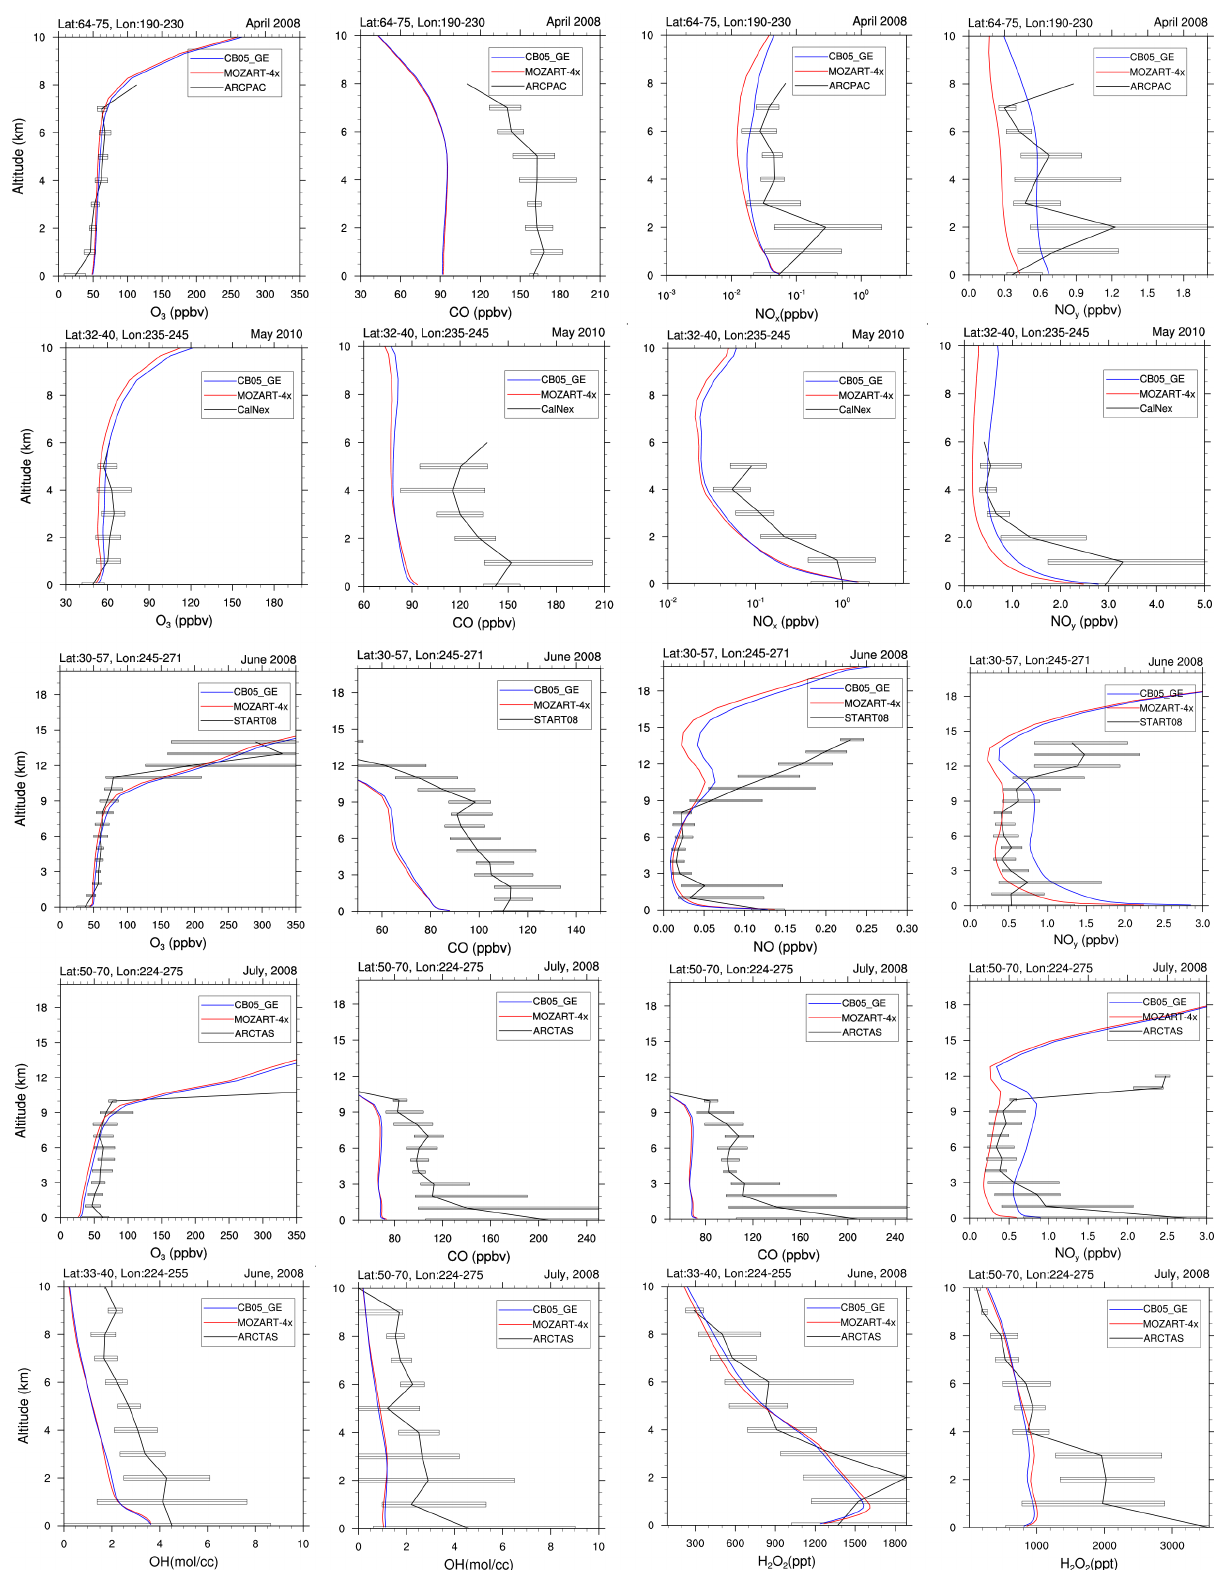
Figure 4. Simulated vertical profiles of O 3 , CO, NO x , and NO y , against aircraft measurements. The black solid line represents observations from aircraft measurements (Pan et al., 2010; Brock et al., 2011; Ryerson et al., 2013; Jacob et al., 2010). The red solid and blue solid lines represent model output from MOZART-4x and CB05_GE,